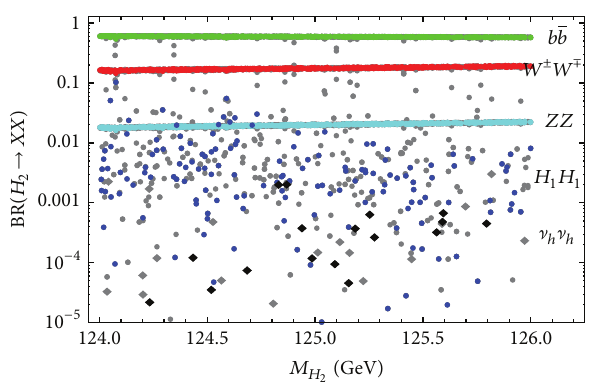
Figure 6: Branching ratios for the 125 GeV Higgs boson ( 𝐻 2 ). The decay into heavy neutrinos is displayed with diamonds. All other decays are displayed with circles. Gray points are excluded by the low energy observables and by HiggsBounds . The decay into 𝐶𝑃 - odd sneutrinos is not shown.